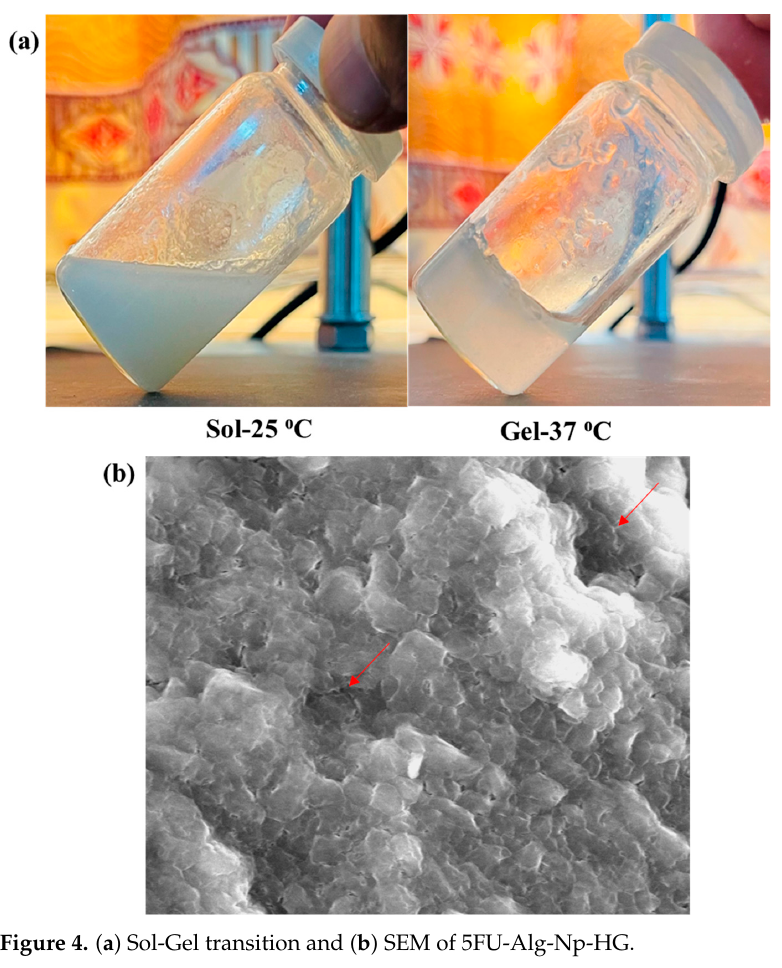
Figure 4. ( a ) Sol-Gel transition and ( b ) SEM of 5FU-Alg-Np-HG.